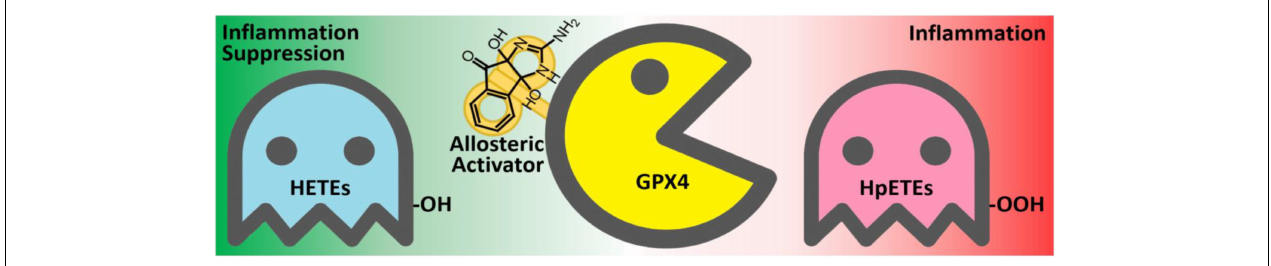
FIGURE 10 | The anti-inflammatory mechanism of the GPX4 allosteric activator compound 102 . GPX4 (yellow) catalyzes the reduction of inflammation-related HpETEs (pink) to generate the corresponding HETEs (light blue). Compound 102 is an allosteric activator of GPX4 and is beneficial to inflammation